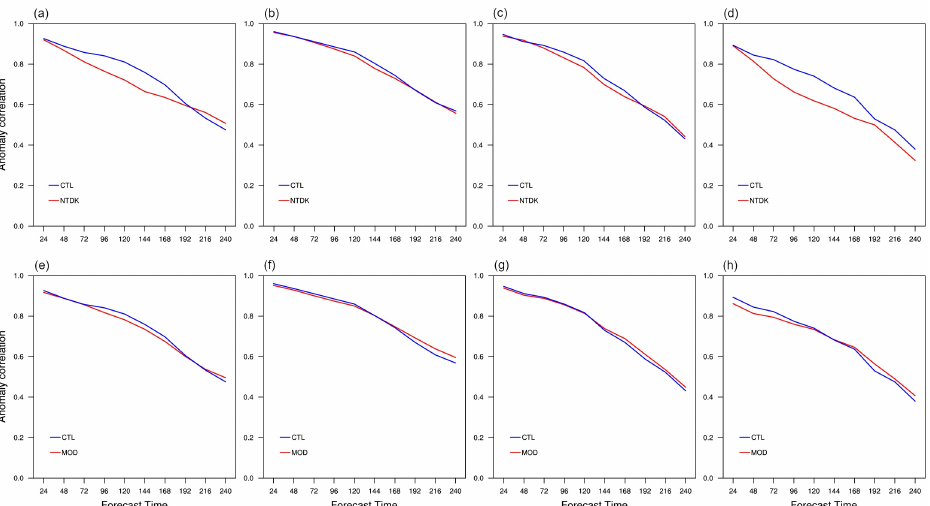
Figure 11. Anomaly correlation for forecasts of the ( a ) 100-, ( b ) 250-, ( c ) 500-, and ( d ) 850-hPa geopotential height in the tropics (20° S–20° N) against the ERA5 analysis data during 1–20 July 2017 from the CTL-COARSE (blue) and NTDK-COARSE (red) experiments and the same anomaly correlation from the CTL-COARSE (blue) and MOD-COARSE (red) experiments ( e – h